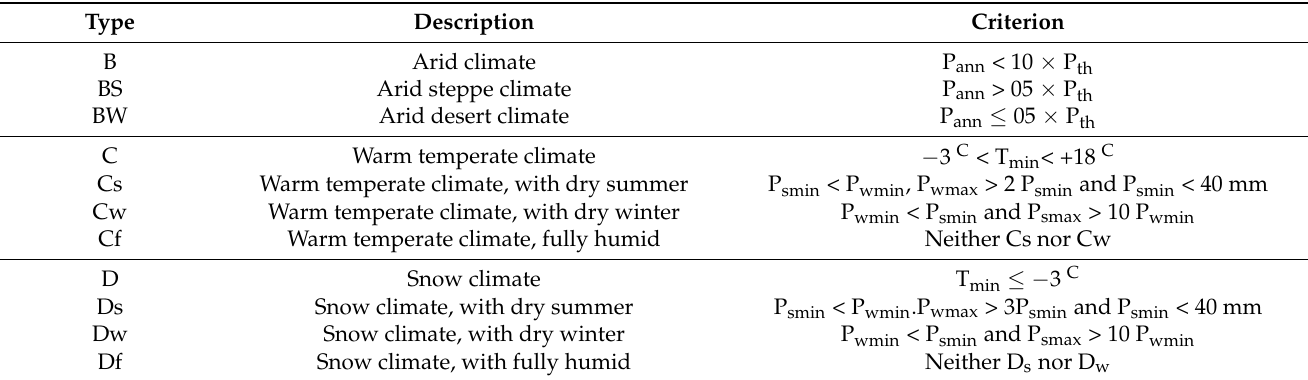
Table 2. Climate classification scheme of study